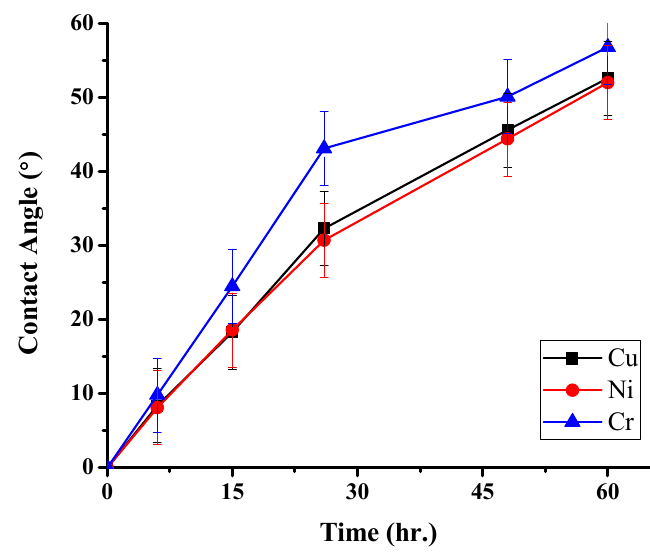
Figure 17. Contact angle vs. time after plasma treatment of Cr, Ni and Cu, respectively.